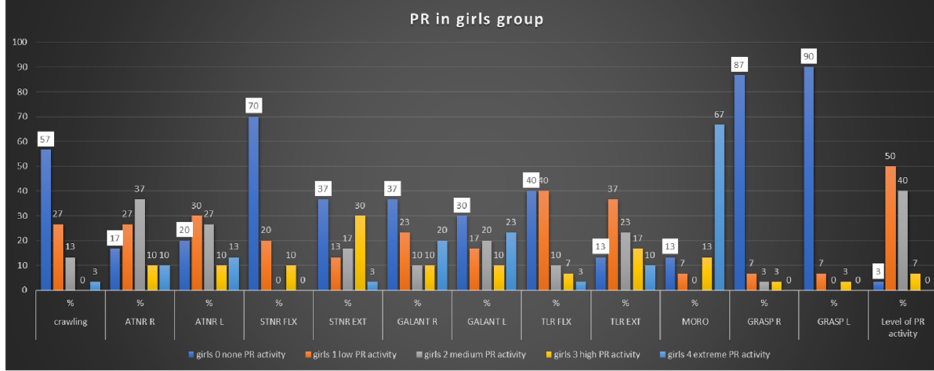
Figure 2. The scale of primitive reflexes (PRs) activity in girls. Percentage of crawling pattern performance and the reflexes activity.